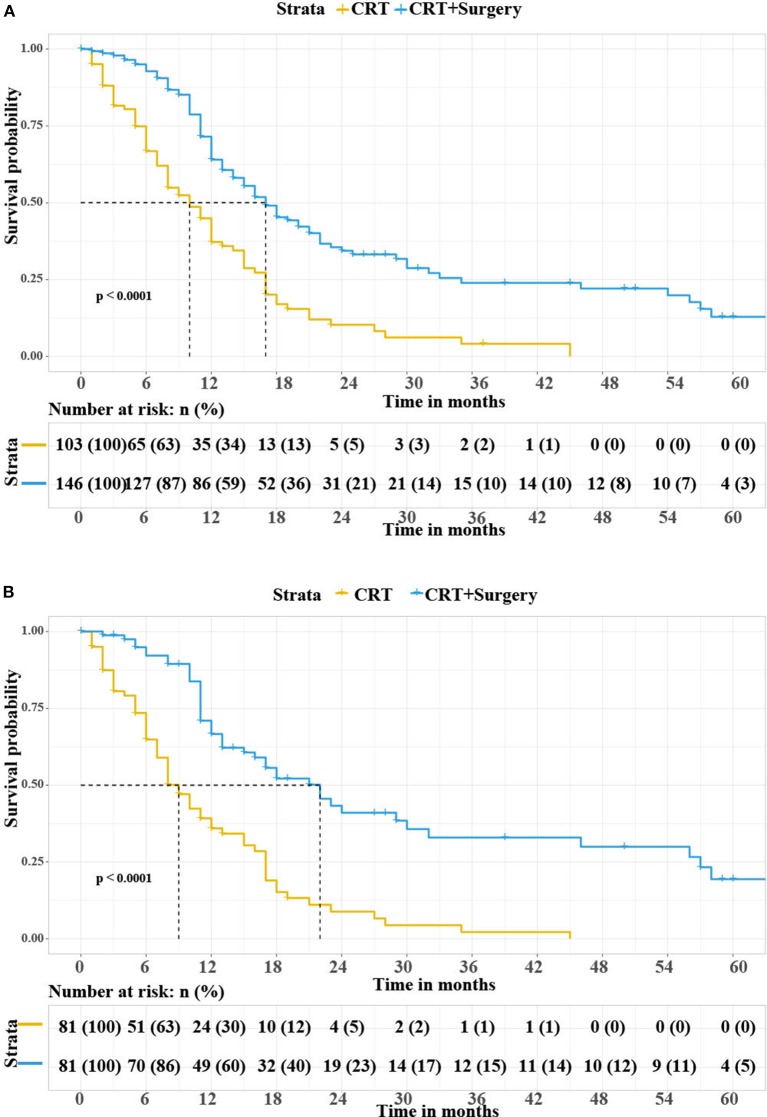
(A) Overall survival rate according to the treatment modalities in all patients. (B) Overall survival rate according to the treatment modalities in matched patients. CRT, chemoradiotherapy.